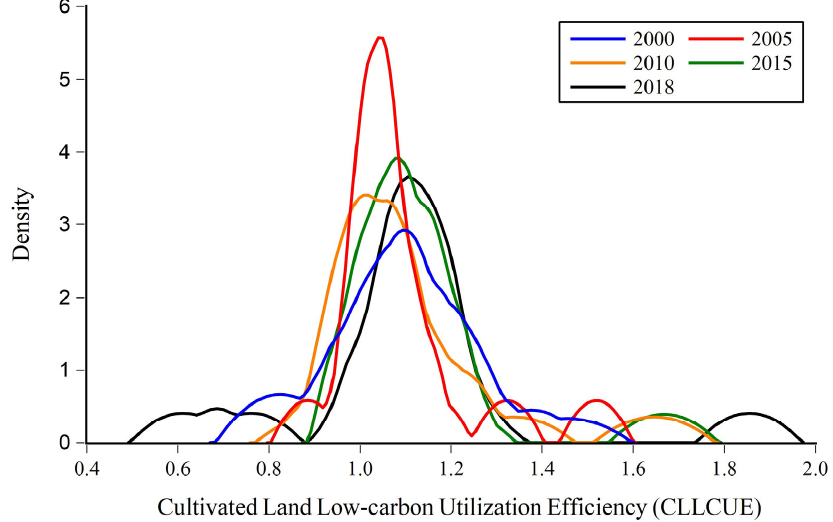
Figure 6. The characteristics of the time-series of cultivated land low-carbon utilization efficiency of the Yangtze River Delta during 2000–2018.